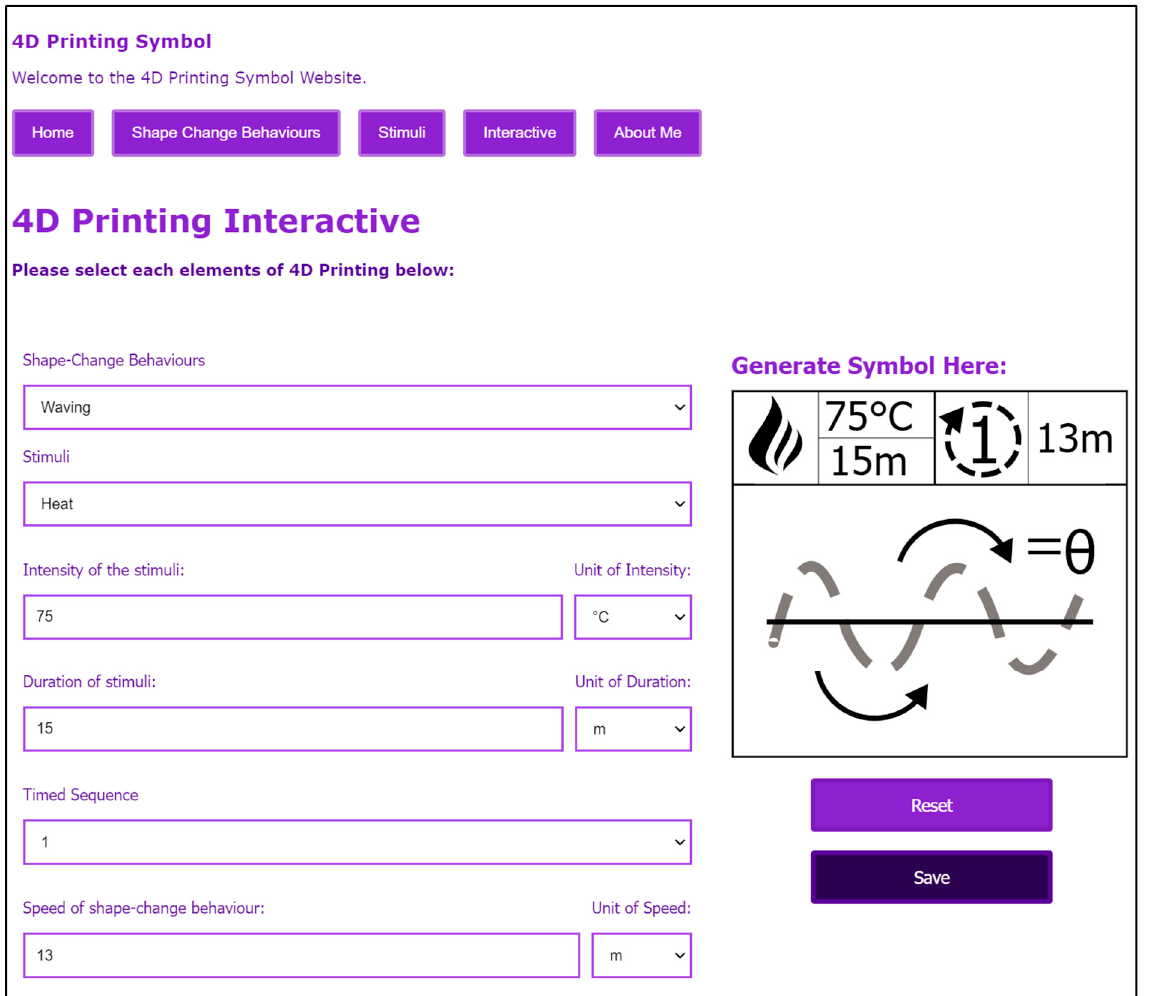
Figure 12. 4D Printing symbol toolkit created by Ezrin Azhar 2021.